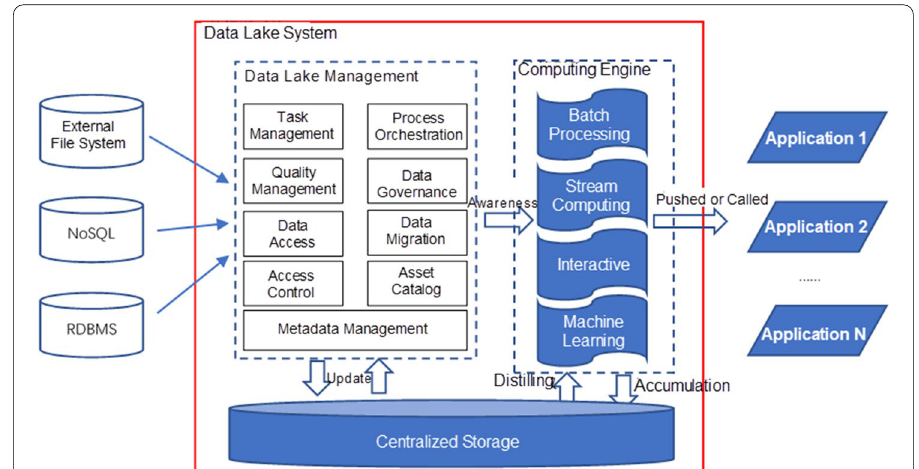
Fig. 1 The overall architecture of the integrated operation and maintenance management and control system